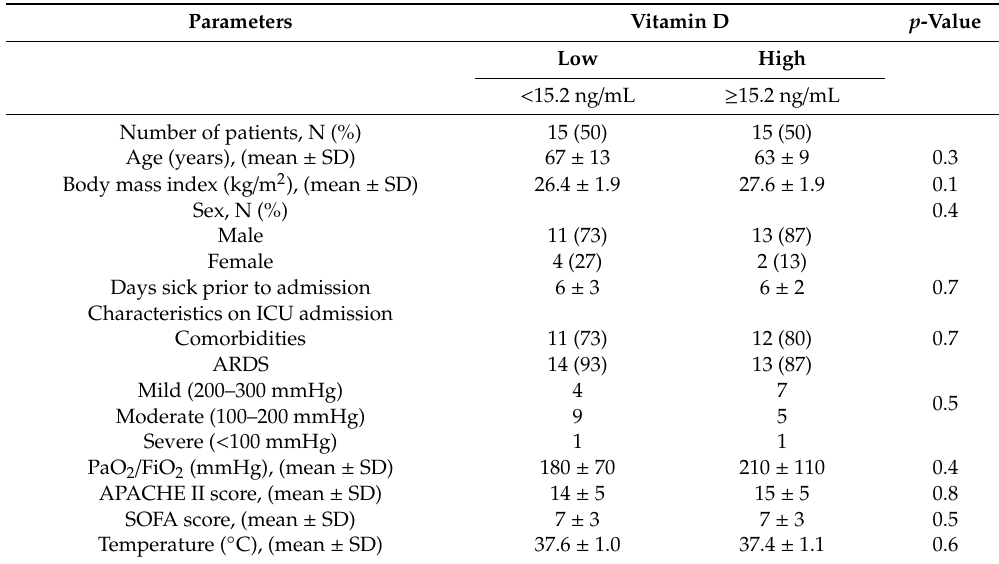
Table 2. Patient characteristics on ICU admission and important outcomes stratified by 25-hydroxyvitamin D